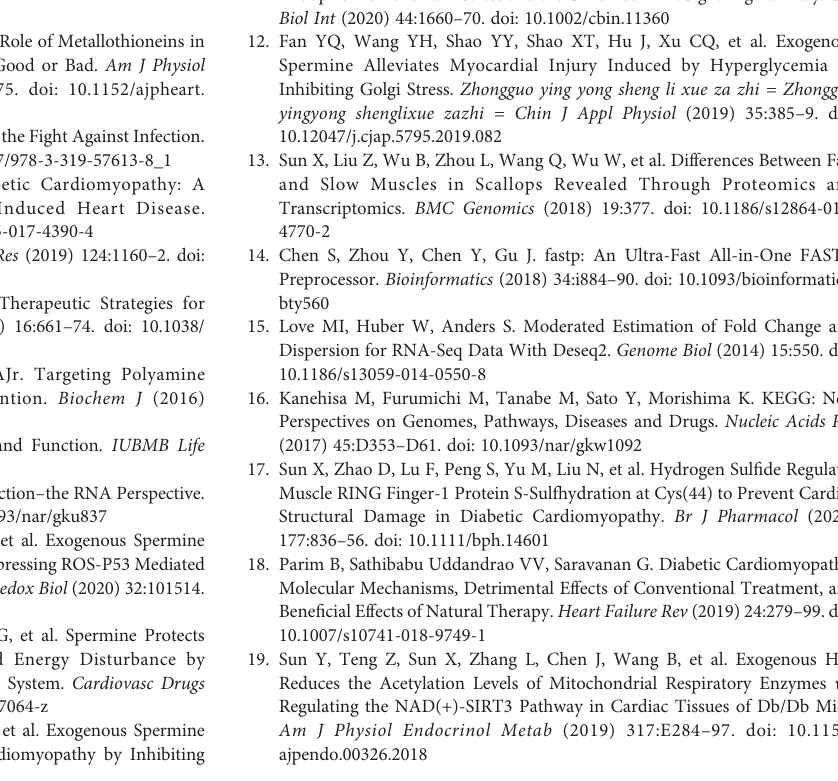
Supplementary Figure 1 | The validation of the cardiac function in the model. (A – E) ThecardiacfunctionwasvalidatedintheCK,DCM,andSPMgroup. (A) Thecardiacinjury and fi brosis were analyzed using HE staining and Collagen I immunohistochemistry. The EF (B) , FS (C) , LVIDd (D) , and LVIDs (E) were